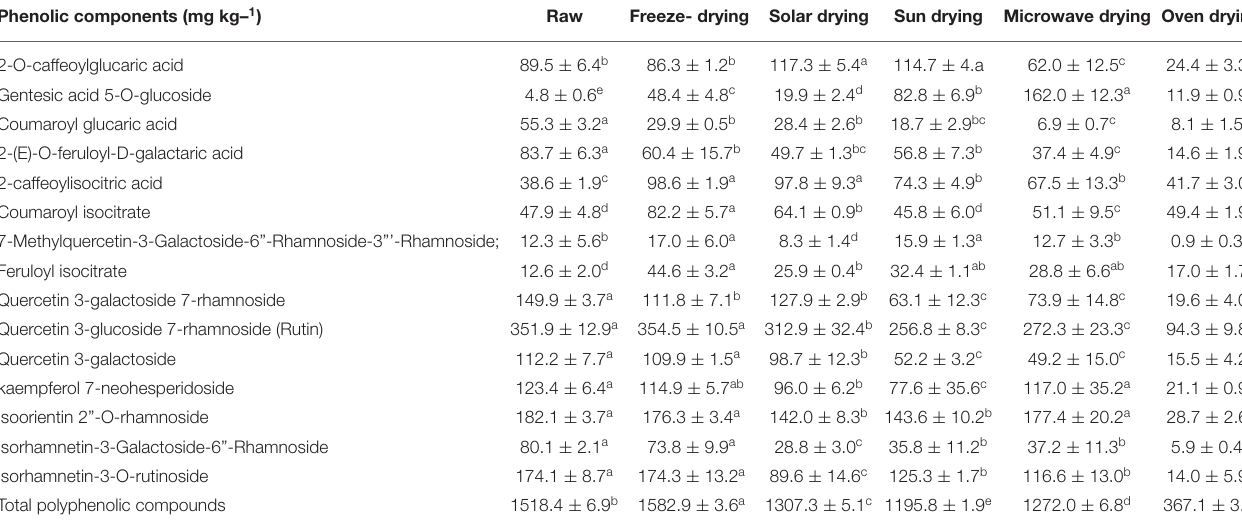
TABLE 3 | Influence of different drying treatments on different phenolic components of leaves of var. Butternut squash ( C. moschata ). Phenolic components (mg kg– 1